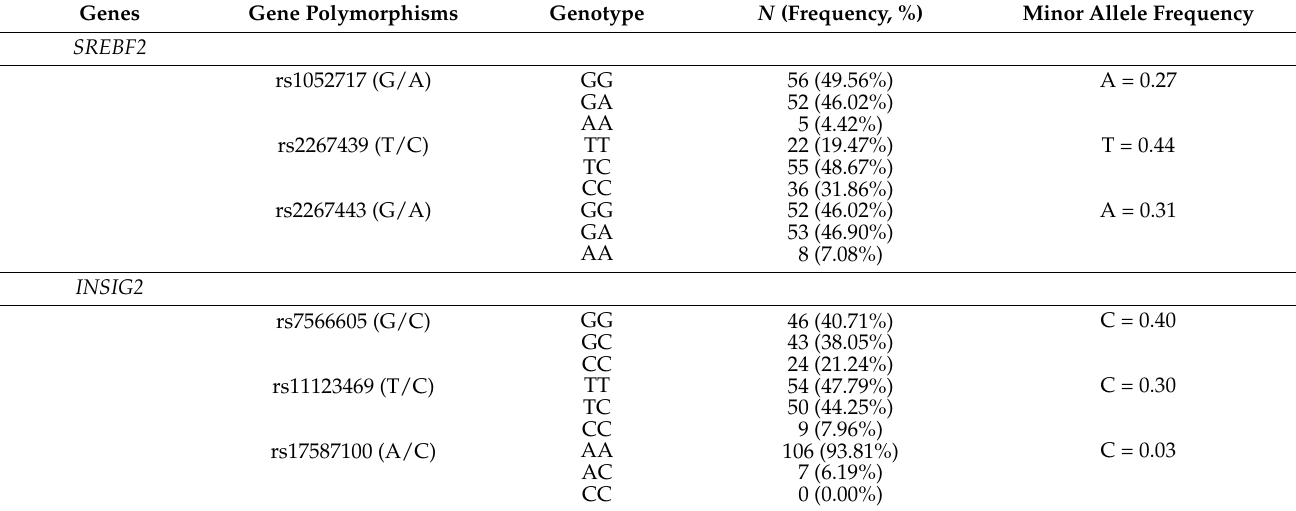
Table 1. Genotype and allele frequencies of the SREBF2 gene and INSIG2 ( n = 113).